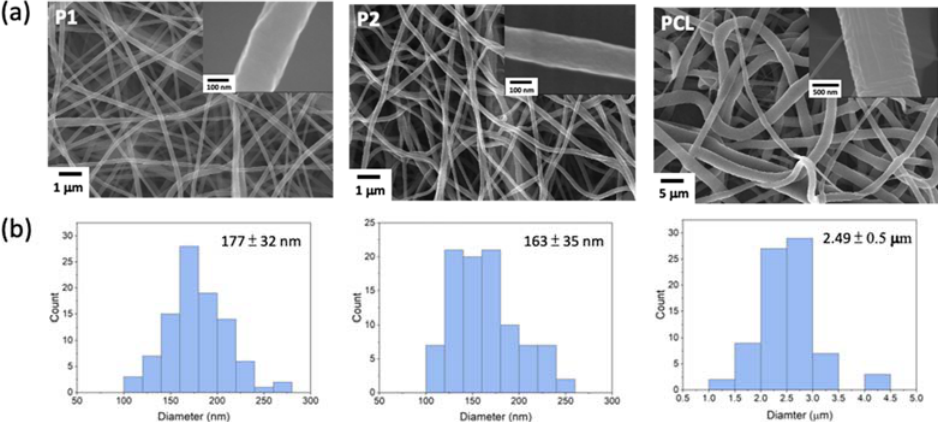
Figure 1. ( a ) FE-SEM images of the prepared ES nanofibers. The inset figures show the enlarged FE-SEM of ES nanofibers. ( b ) The corresponding size distributions of nanofibers: P1 , P2, and PCL.